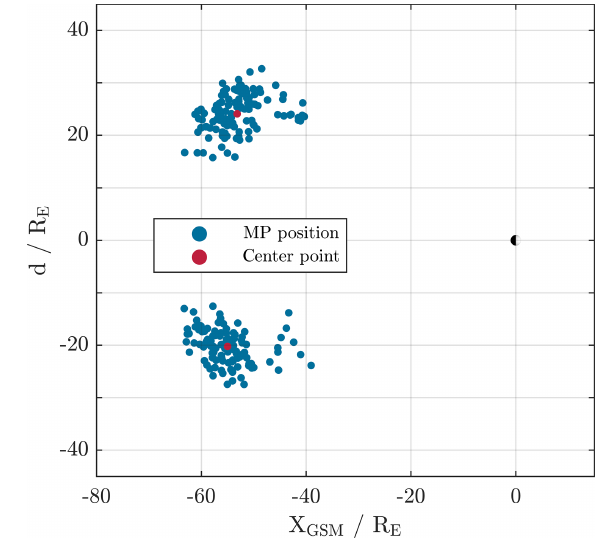
Figure 2. Distribution of MPs displayed on the x GSM d plane, with p d = ± y 2 + z 2 ; see text. The centre points of each independent point cloud is indicated by the red dots.